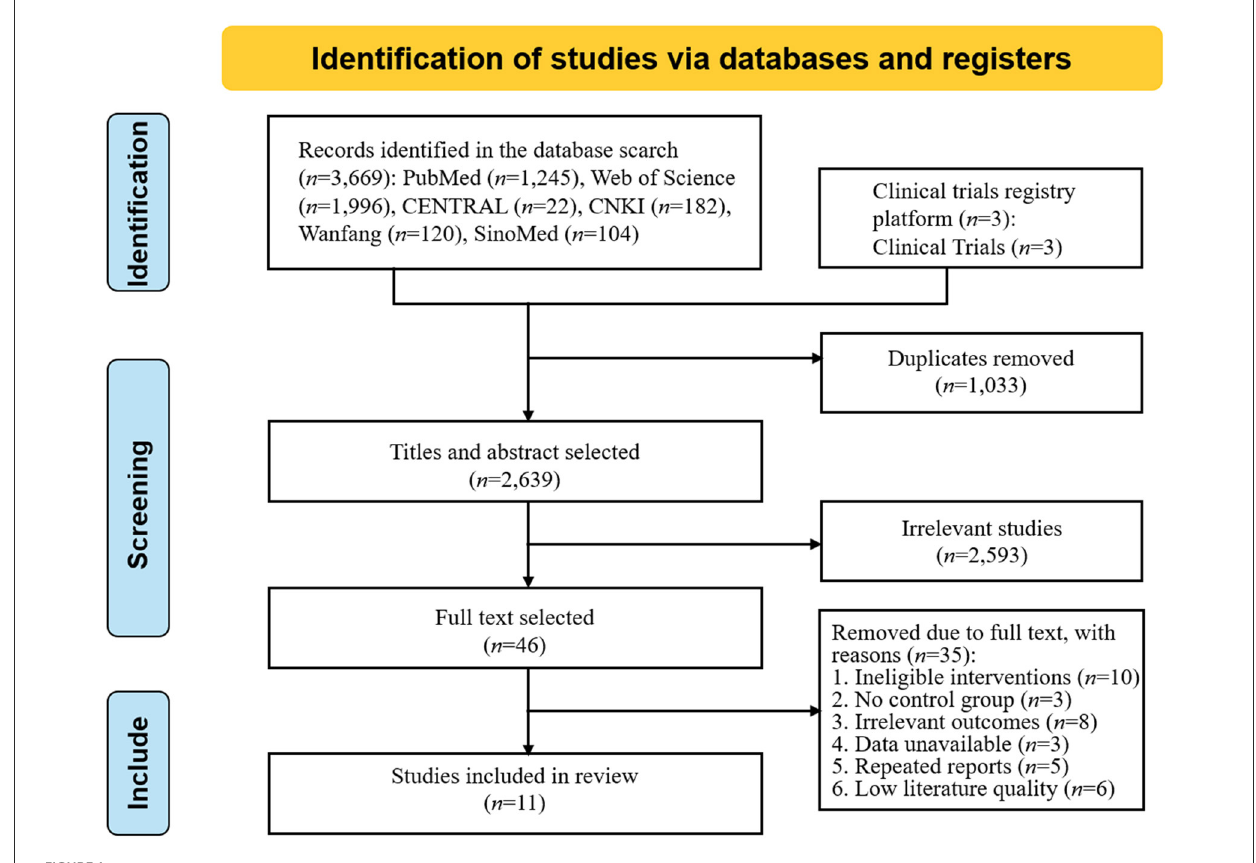
FIGURE1 Screening process of literature